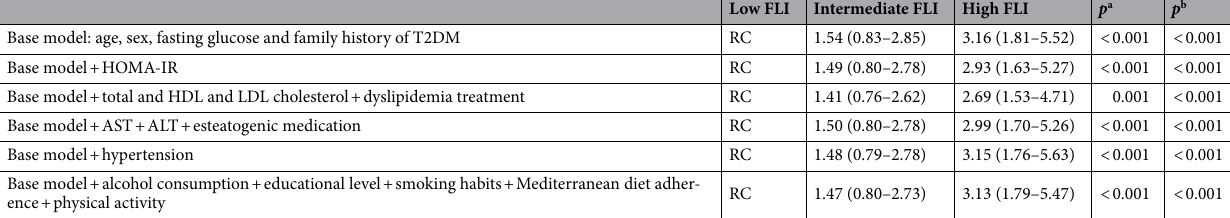
Table 2. Incidence rate ratios and 95% confidence intervals of Poisson robust multivariate regression models for the risk of incident T2DM after 7.5 years of follow-up according to FLI categories in the general population. p a = Significance level in the regression model. p b = Significance level in the p for trend test. RC reference